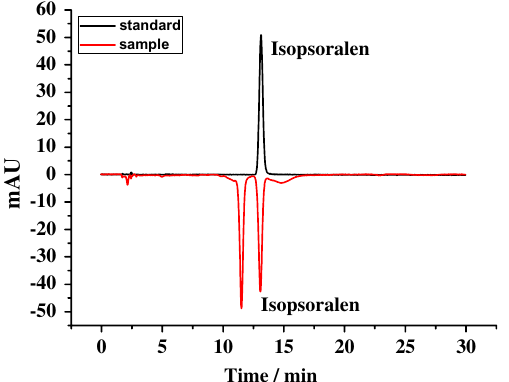
Fig. 1. Chromatograms of reference and Yunkang Oral Liquid.